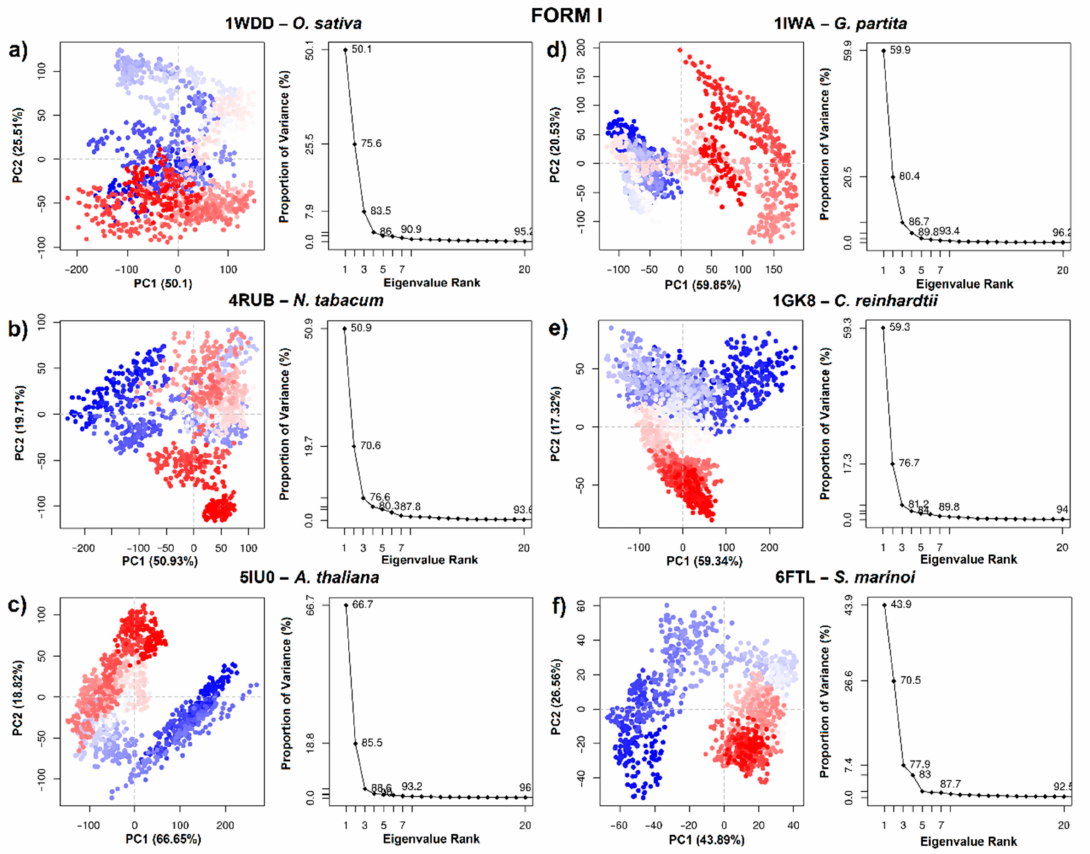
Figure 6. Principal component analysis of RuBisCO isoform I. ( a ) O. sativa (1WDD); ( b ) N. tabacum (4RUB); ( c ) A. thaliana (5IU0); ( d ) G. partita (1IWA); ( e ) C. reinhardtii (1GK8) and ( f ) S. marinoi (6FTL).